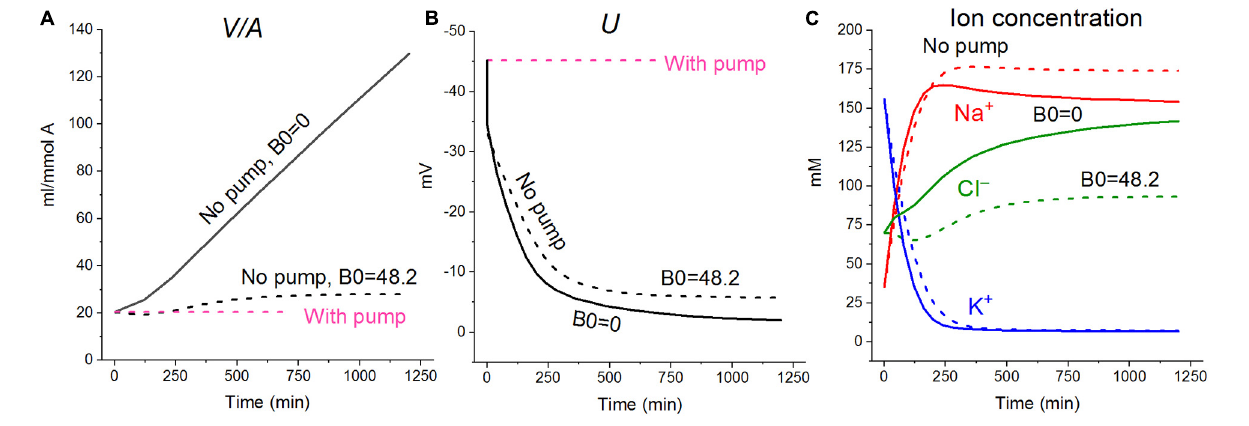
FIGURE 2 | Effect of impermeant external osmolytes B o on cell swelling caused by blocking the pump calculated for the U937 cell model with a full set of cotransporters (NC + KC + NKCC) at the unchanged over time parameters as in U937 cells, equilibrated with standard RPMI medium. The calculation was carried out for B o = 0 (solid lines, [Na] o 149.2, [K] o 5.8, [Cl] o 155 mM) or for standard medium (dashed lines, [Na] o 140, [K] o 5.8; [Cl] o 116 mM, [B] o 48.2 mM). The pump was blocked at t = 0 by changing the beta from 0.039 to 0 (“No pump” in the figure). The other parameters remain constant and are shown in Table 2 , cells A with a full set of